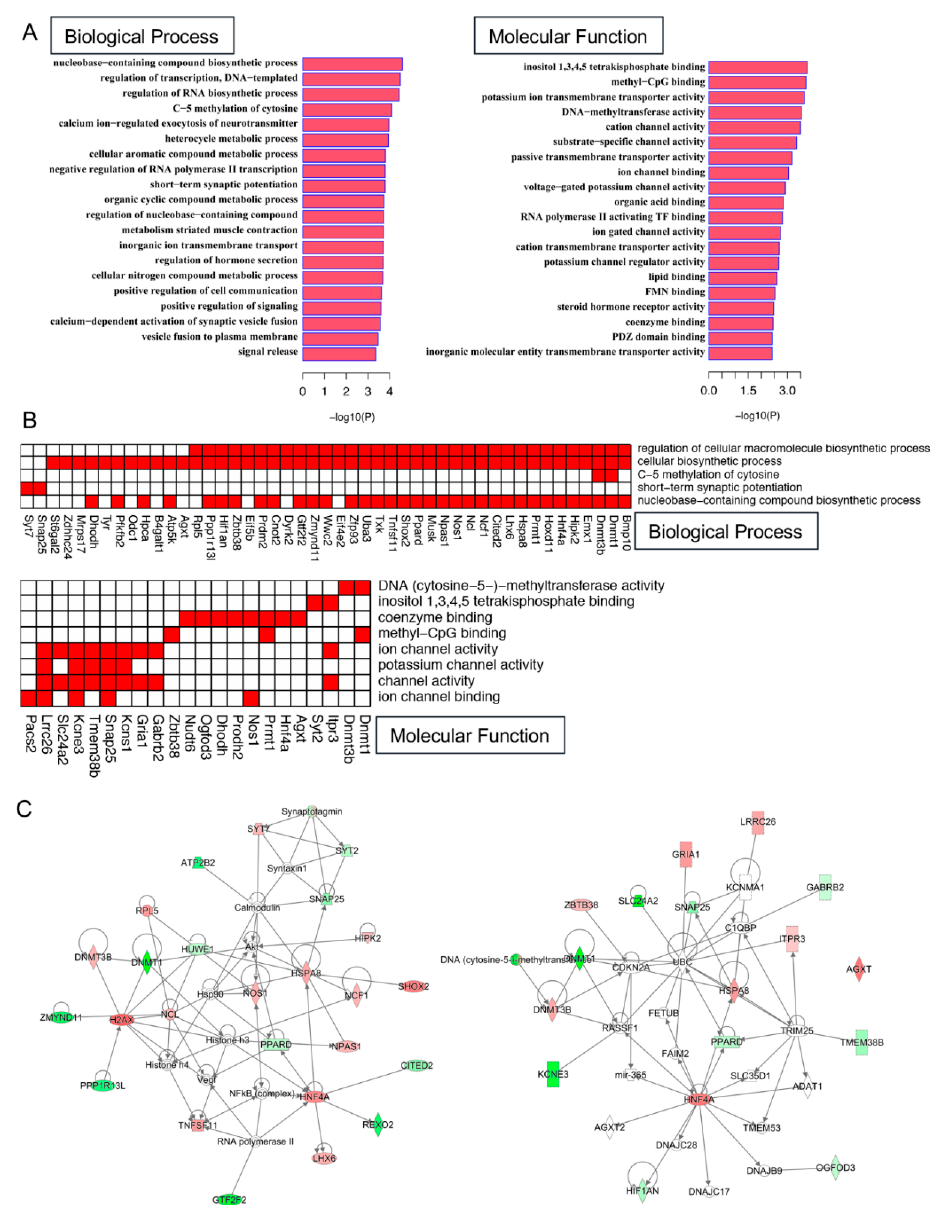
Figure 4. The GO prediction for biological process and molecular function of targeted EV mRNAs. ( A ) Top 10 significantly enriched categories in biological process (BP) and molecular function (MF) of genes common to all stem / progenitor cell-derived EVs. ( B ) Plot shows gene members within significantly enriched gene ontology categories in BP and MF of the dysregulated genes. ( C ) Gene interaction networks of significant genes. Left: genes from the top enriched gene ontology categories within biological process; Right: genes from the top enriched gene ontology categories within molecular